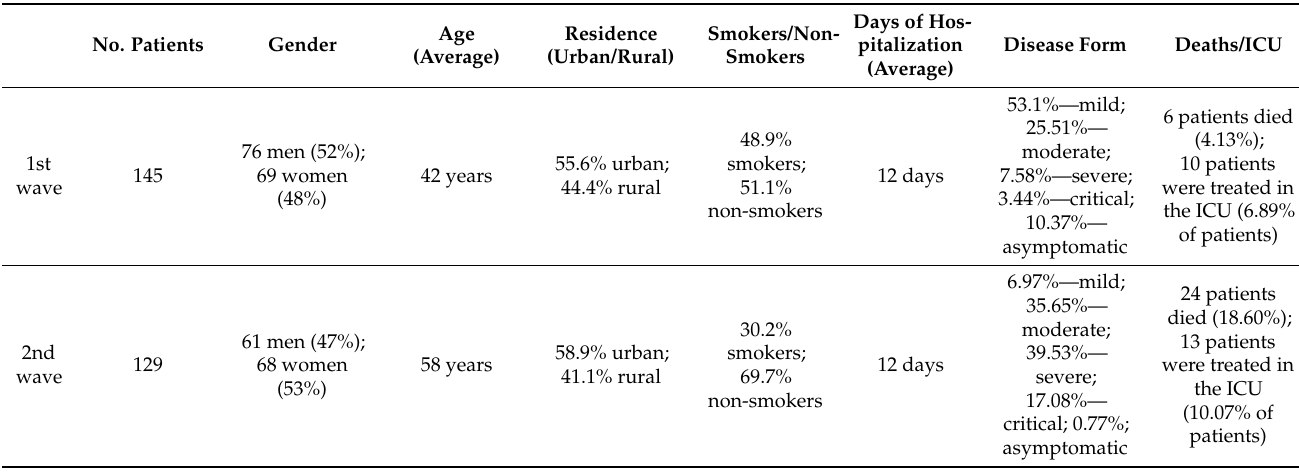
Table 1. Description of individual features, demographics and other characteristics of patients analyzed in both samples (a comparative approach between the two waves of infection with SARS-COV2 in Romania during 2020). No. Patients